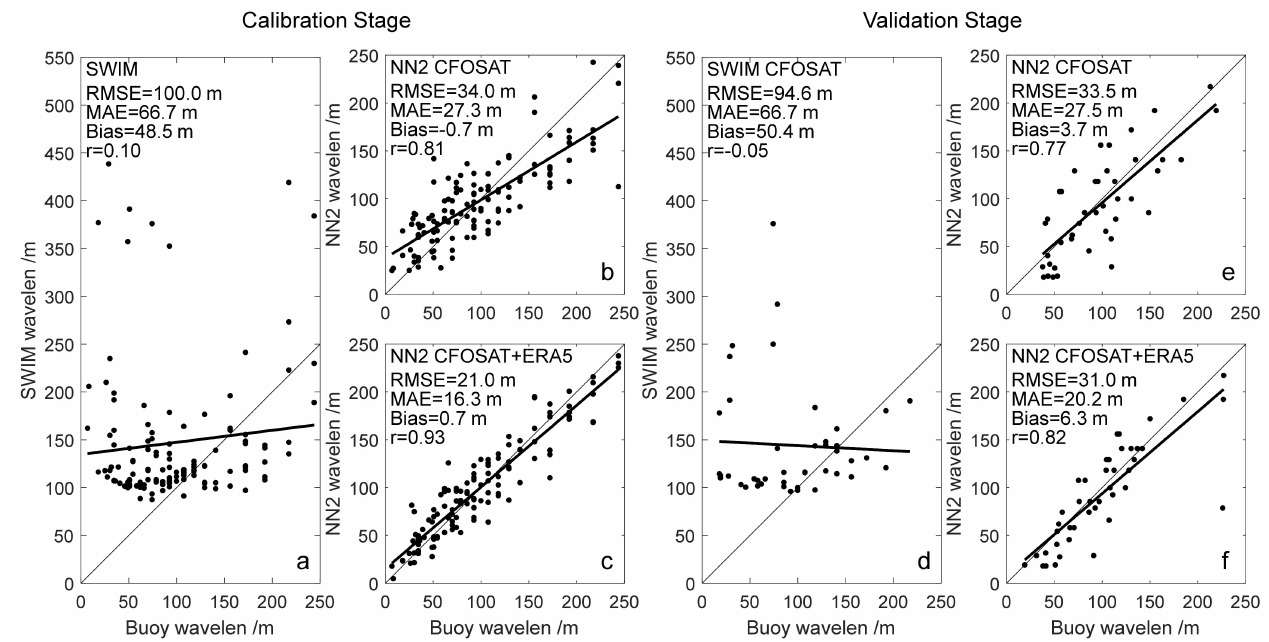
Figure 10. Typical calibration (left part, ( a – c )) and validation (right part, ( d – f )) example of the NN2 model in which the RMSE of validation sample of the SWIM wavelength is closest to median out of 1000 samplings (i.e., the red lines of the SWIM boxplots in the upper-left panels of Figures 7 and 9); ( a , d ) are the comparisons of wavelengths by buoy A and SWIM in scatters; ( b , e ) and ( c , f ) are the scattering comparisons of wavelengths from buoy A and NN2 model with CFOSAT parameters and CFOSAT + ERA5 parameters, respectively.